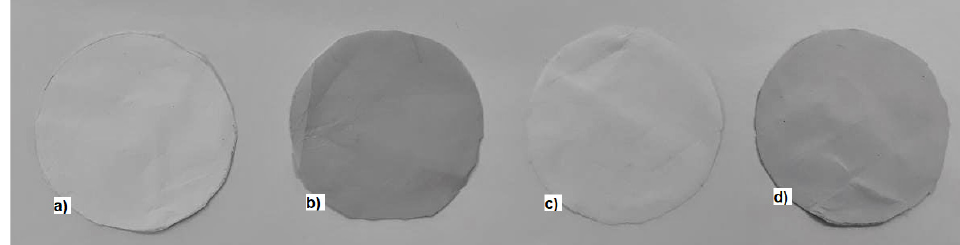
Figure 4. Images of polymeric fibers of PBAT/PLA ( a ) with 10% TiO 2 -R; ( b ) with 1% Fe 3 O 4 ; ( c ) pure; and ( d ) with 10% TiO 2 -R + 1% Fe 3 O 4 .